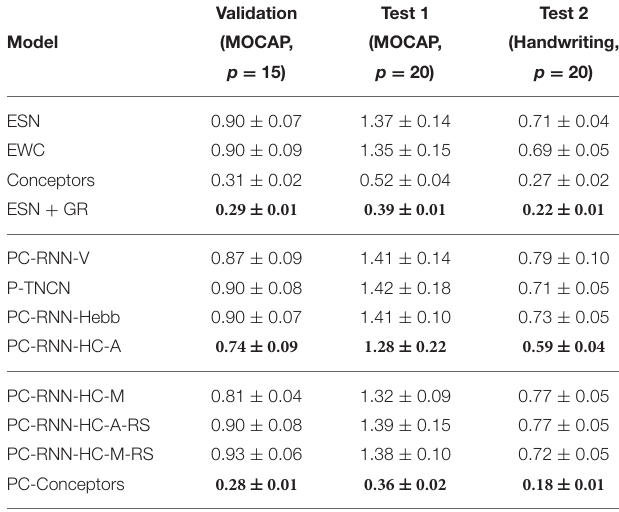
TABLE 2 | Average prediction error after training on all p